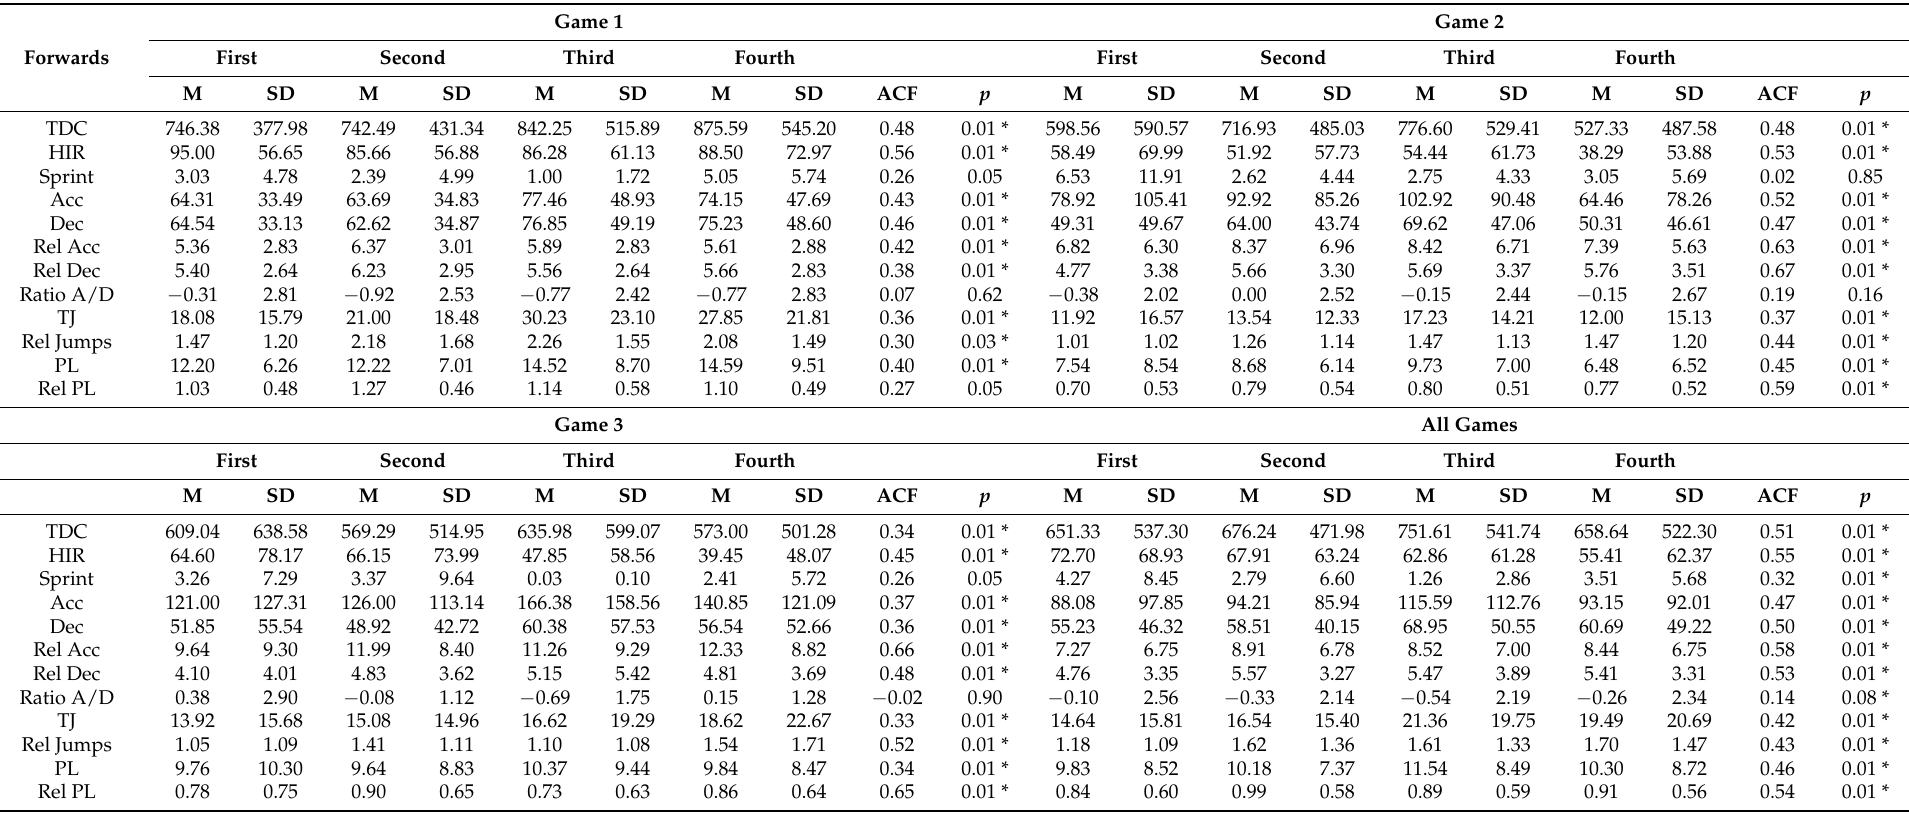
Table 3. Descriptive statistics for physical demands during games and quarters for forward players (persistency of performances via ACF and p